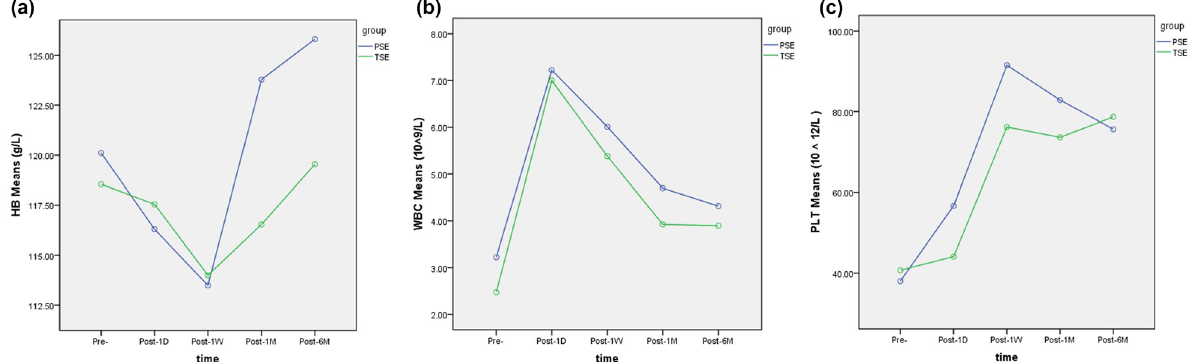
Figure 3: Changes of blood cells before and after PSE and TSE. ( a ) Changes of HB before and after PSE and TSE. ( b ) Changes of WBC counts before and after PSE and TSE. ( c ) Changes of PLT counts before and after PSE and TSE. HB: hemoglobin; MCV: mean corpuscular volume;